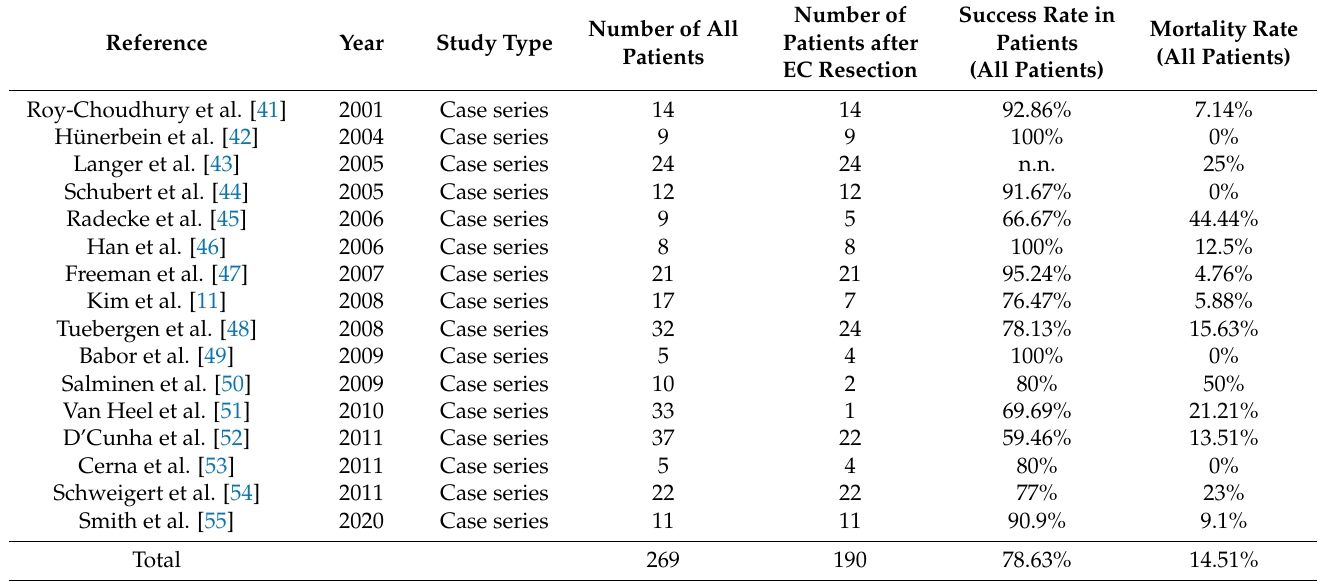
Table 1. Publications with more than five patients included with stent-based therapy in patients with AI after EC